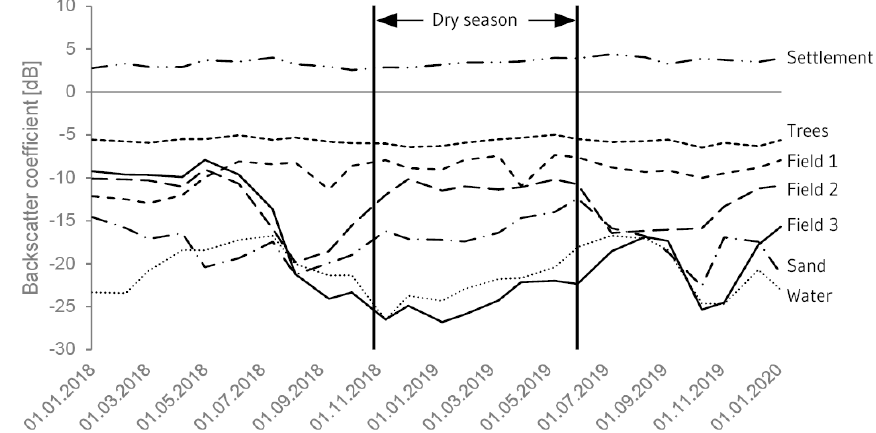
Figure 3. Mean monthly backscatter of different land cover types (one patch per type; the location of the patches is shown in Fig. A1) between January 2018 and February 2020, obtained from the C band of Sentinel-1. Per month, between one and six images are averaged.